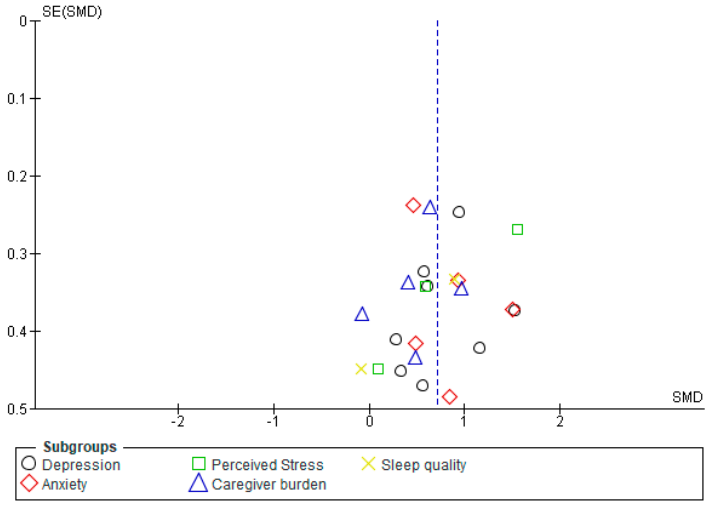
Figure 3. General risk of bias.